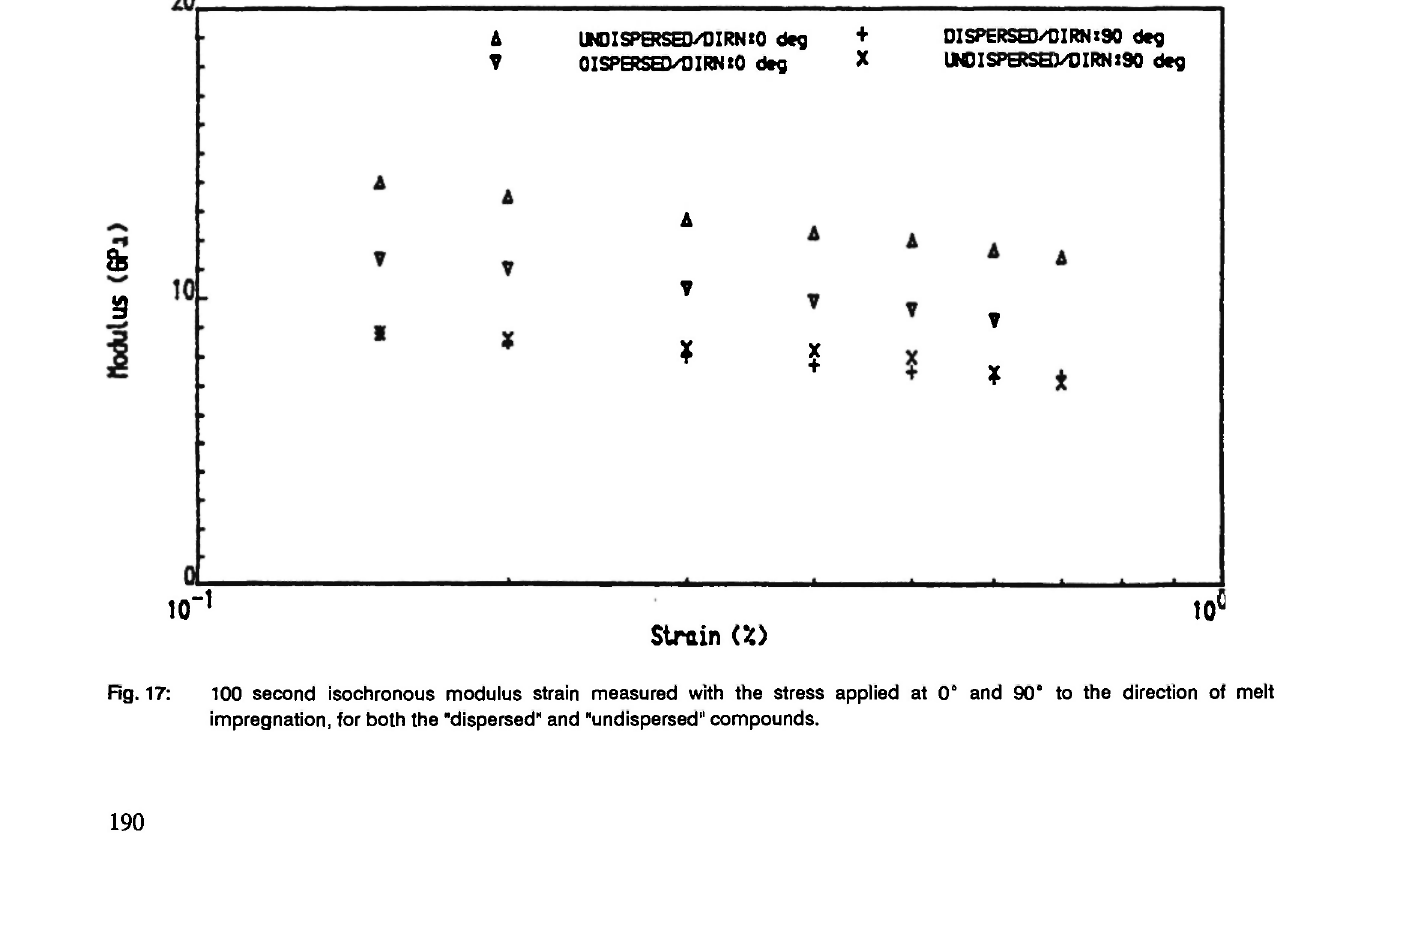
Fig. 17: 100 second isochronous modulus strain measured with the stress applied at 0° and 90° to the direction ot melt impregnation, for both the "dispersed" and "undispersed"